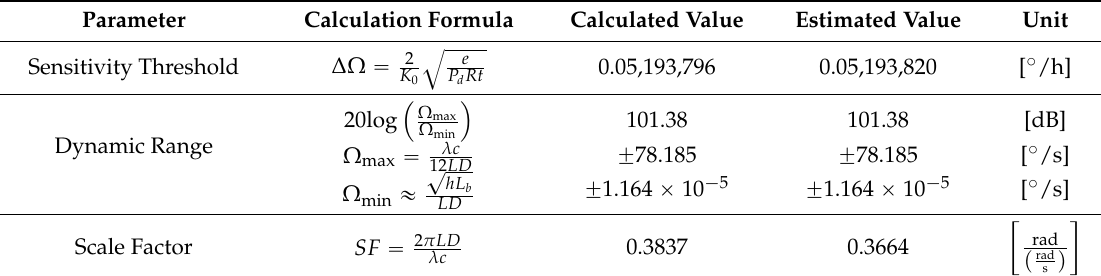
Table 2. Performance parameters of the IFOG prototype (analog closed loop